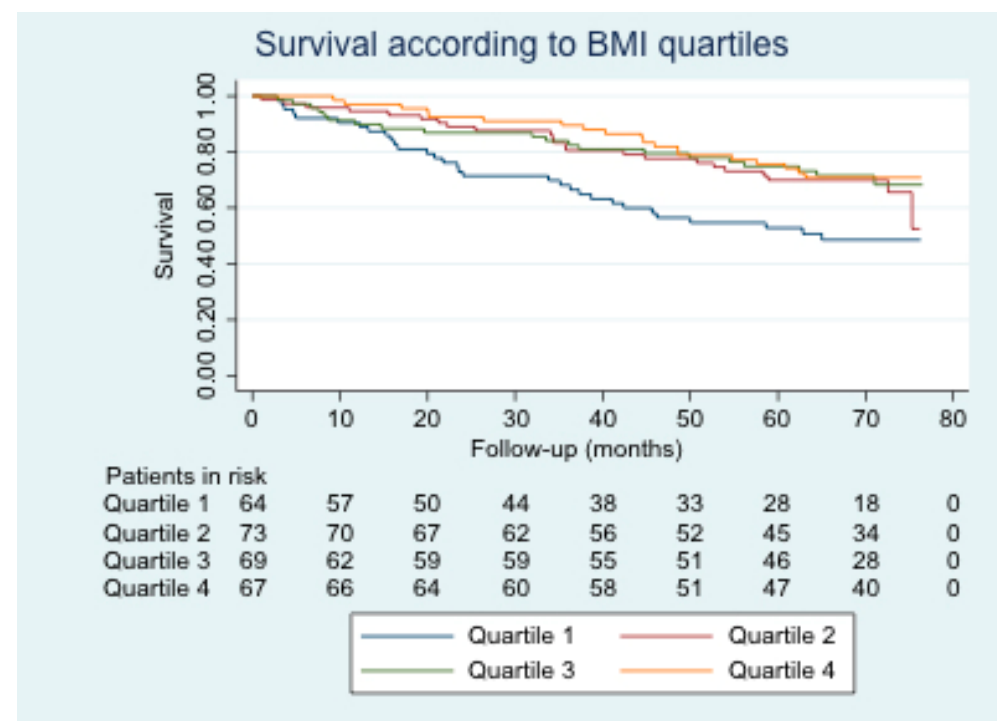
Figure 1. Overall survival according to the presence or absence of pneumonia. Table5. SurvivalofeachBMIquartile, log-rank, and p